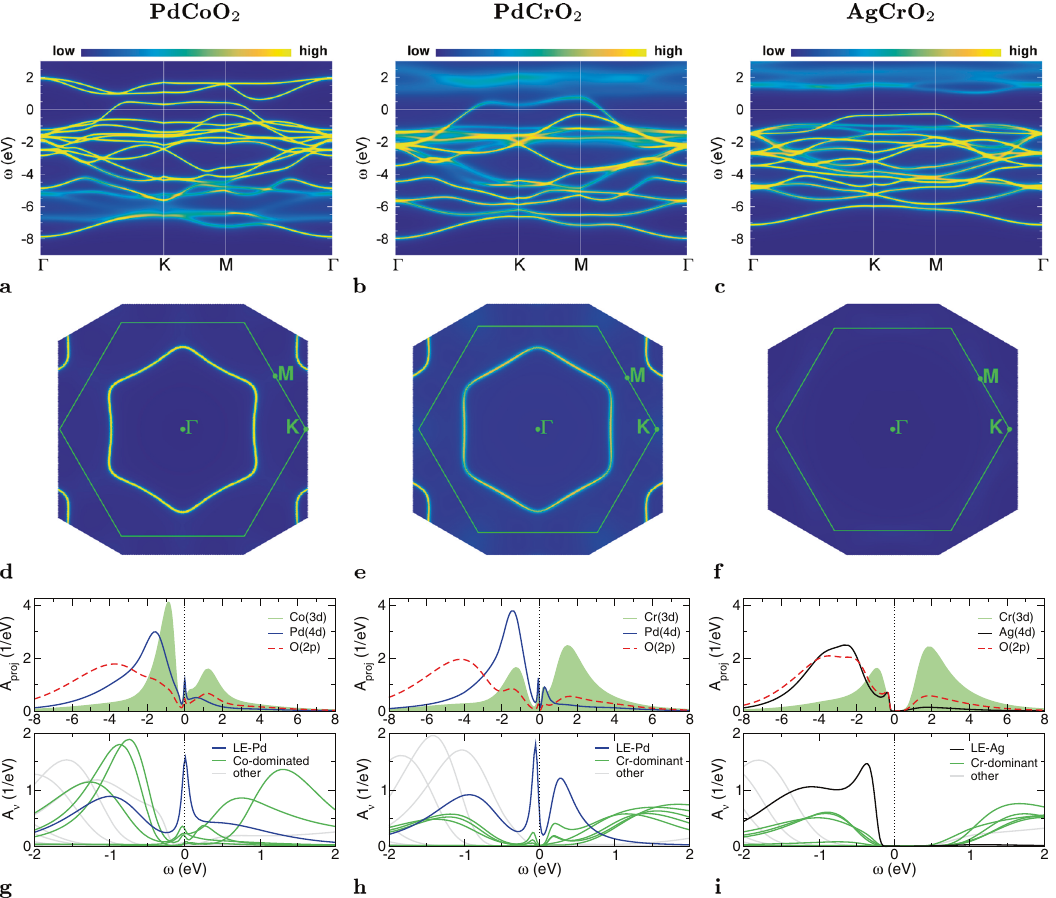
Fig. 4 Spectral properties of PdCoO 2 , PdCrO 2 and AgCrO 2 according to paramagnetic DFT + DMFT. a – c k -resolved spectral function A ( k , ω ) along high symmetry lines in the k z = 0 plane. d – f Interacting Fermi surface in the k z = 0 plane. g – i Site- and orbital-projected spectral function A proj ( ω ) (top) and Bloch-resolved spectral function A ν ( ω ) (bottom), see text, respectively.